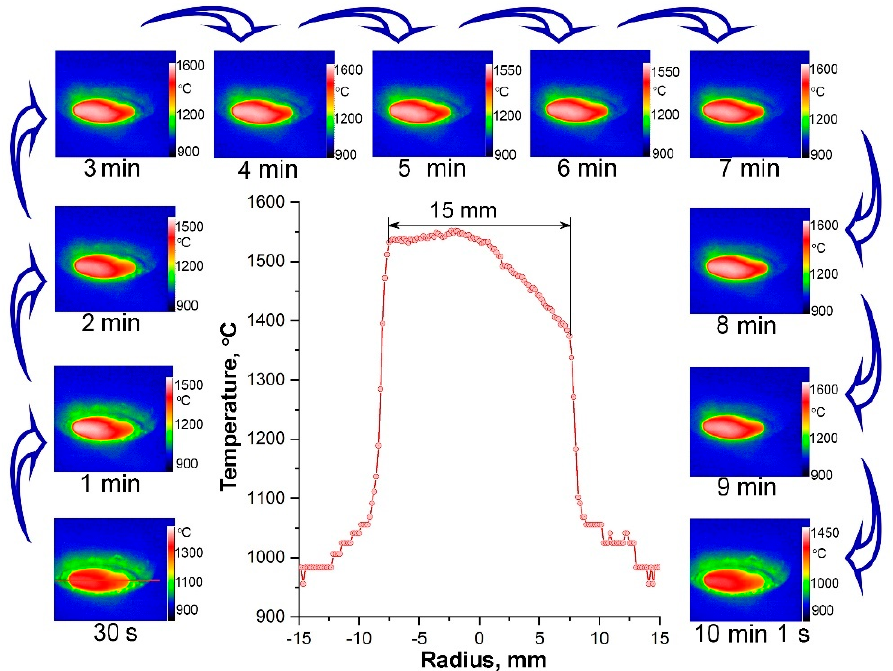
Figure 7. The thermal images at specific moments of the experiment and typical temperature distribution over the diameter of the ZHSC sample (300 s).